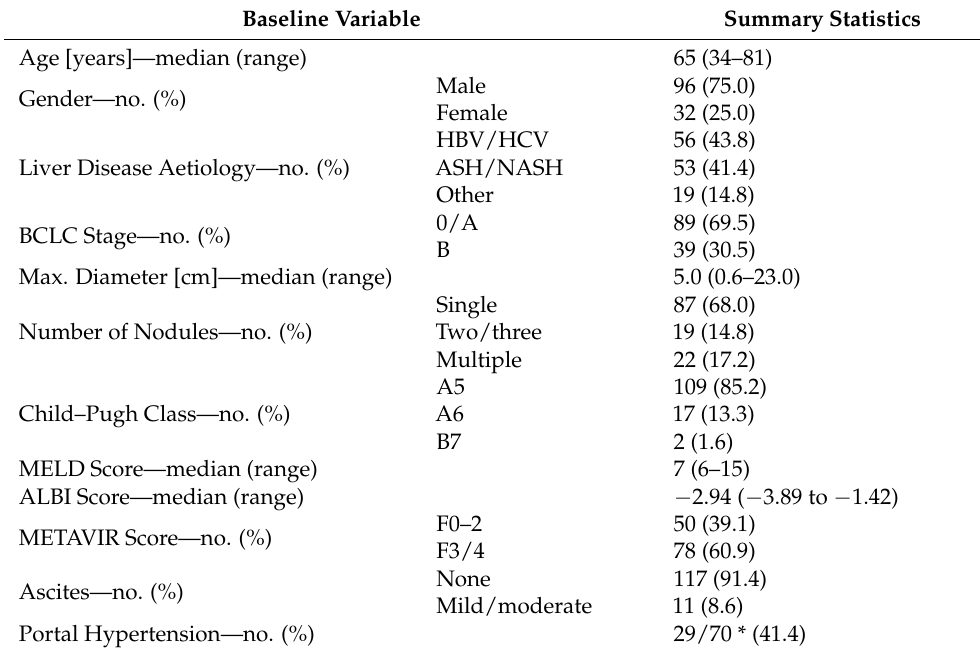
Table 1. Baseline